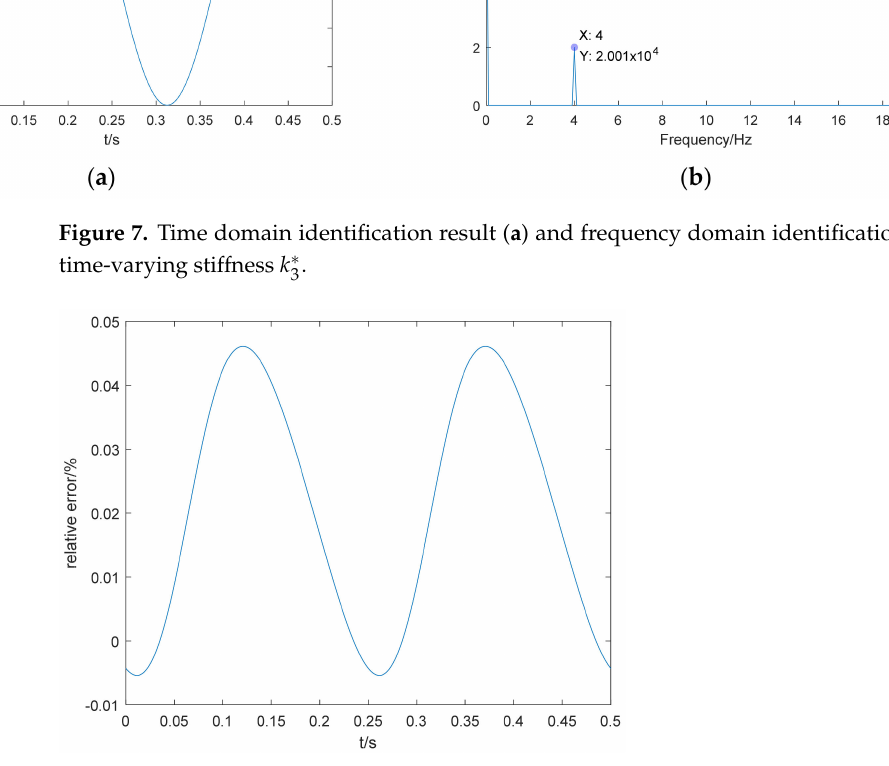
identification 3